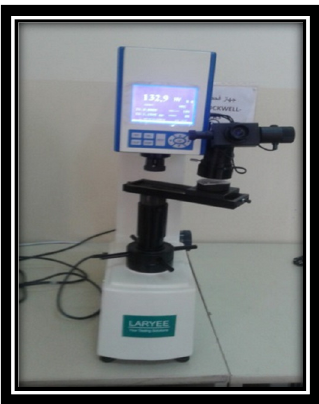
Fig. 8 . Light Microscope Test.